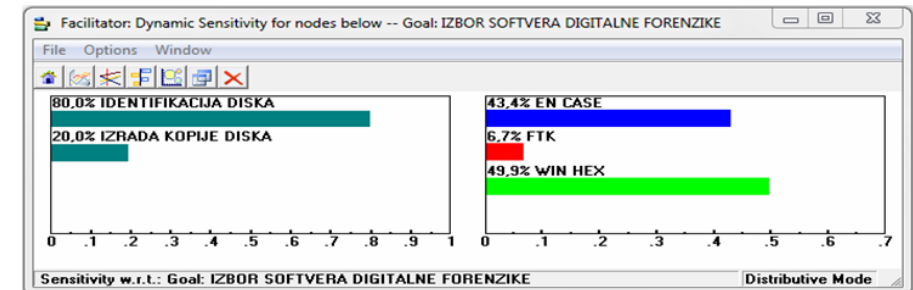
Figure 8 – Revised graph of the dynamic analysis - the "DISK IDENTIFICATION" criterion Рис . 8 – Измененные графики динамического анализа - по критерию " ИДЕНТИФИКАЦИЯ ДИСКА